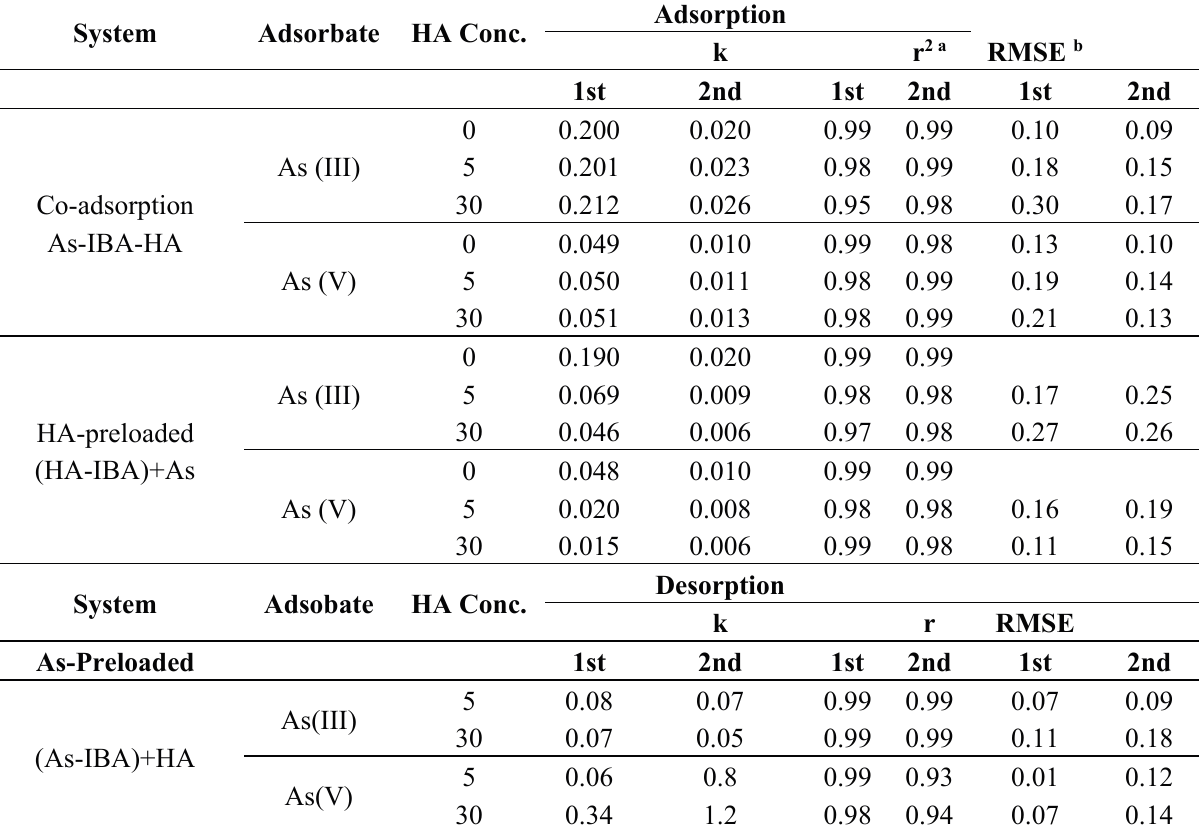
Table 1. Model Fitting Parameters of pseudo 1st and 2nd order models for adsorption and desorption kinetics of As on